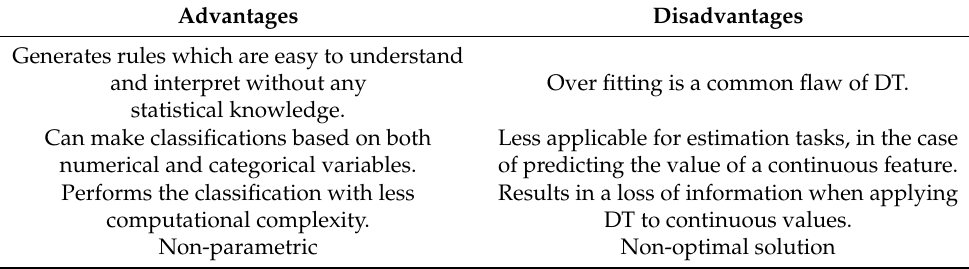
Table 2. Advantages and disadvantages of